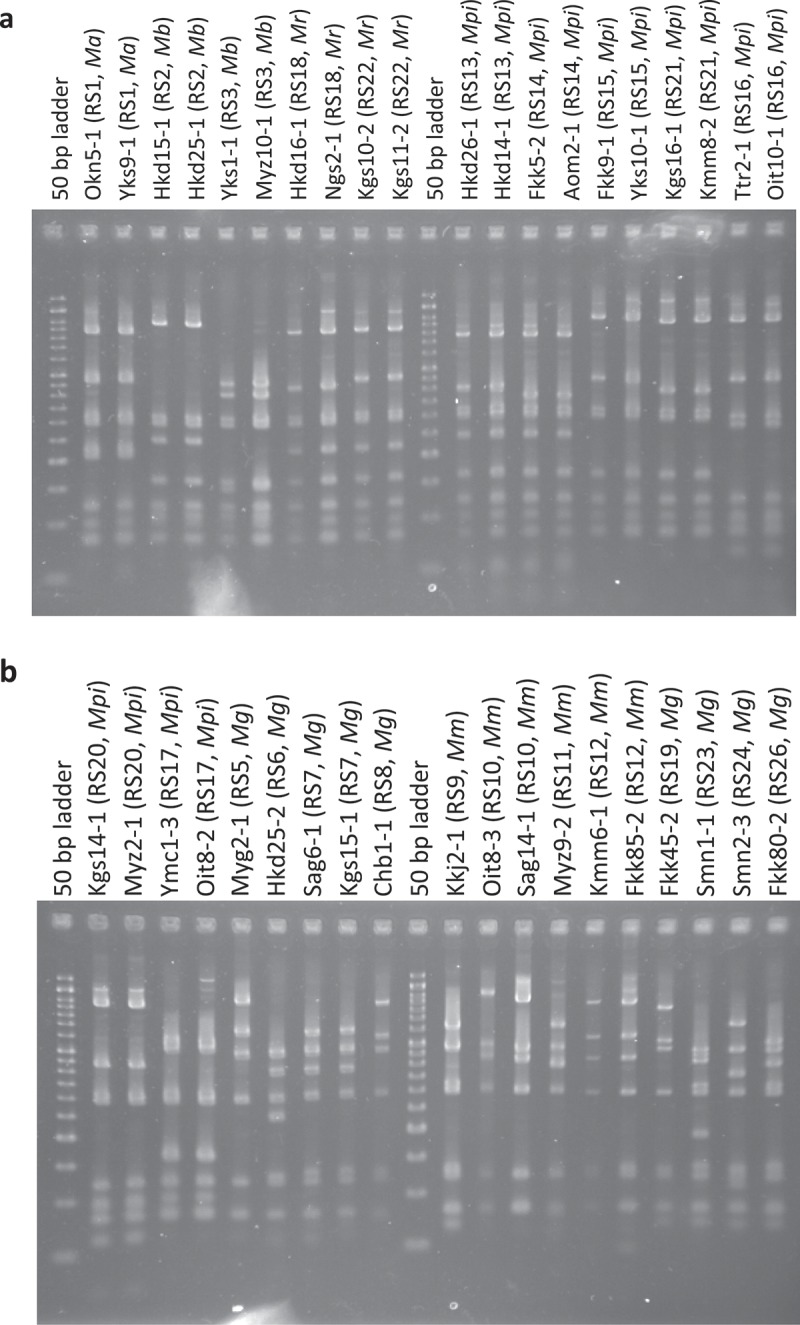
PCR–RFLP profiles of Metarhizium spp. (amplicons of rDNA IGS digested with HaeIII). a. Profiles of 20 isolates that are classified into 10 genotypes (RS1–3, 13–16, 18, 21, 22). b. Profiles of 19 isolates that classified into 14 genotypes (RS5–12, 17, 19, 20, 23, 24, 26). The size marker consists of 17 fragments between 50 and 1200 bp (every 50 bp up to 500 bp, every 100 bp from 500 bp to 1000 bp, 1200 bp, and 1500 bp). The characters after the isolate names indicate the genotypes of PCR–RFLP and species identified by the 5′-EF1-α sequences. The names of Metarhizium spp. are abbreviated as follows: Ma, M. anisopliae; Mb, M. brunneum; Mg, M. guizhouense; Mm, M. majus; Mpi, M. pingshaense; Mr, M. robertsii.